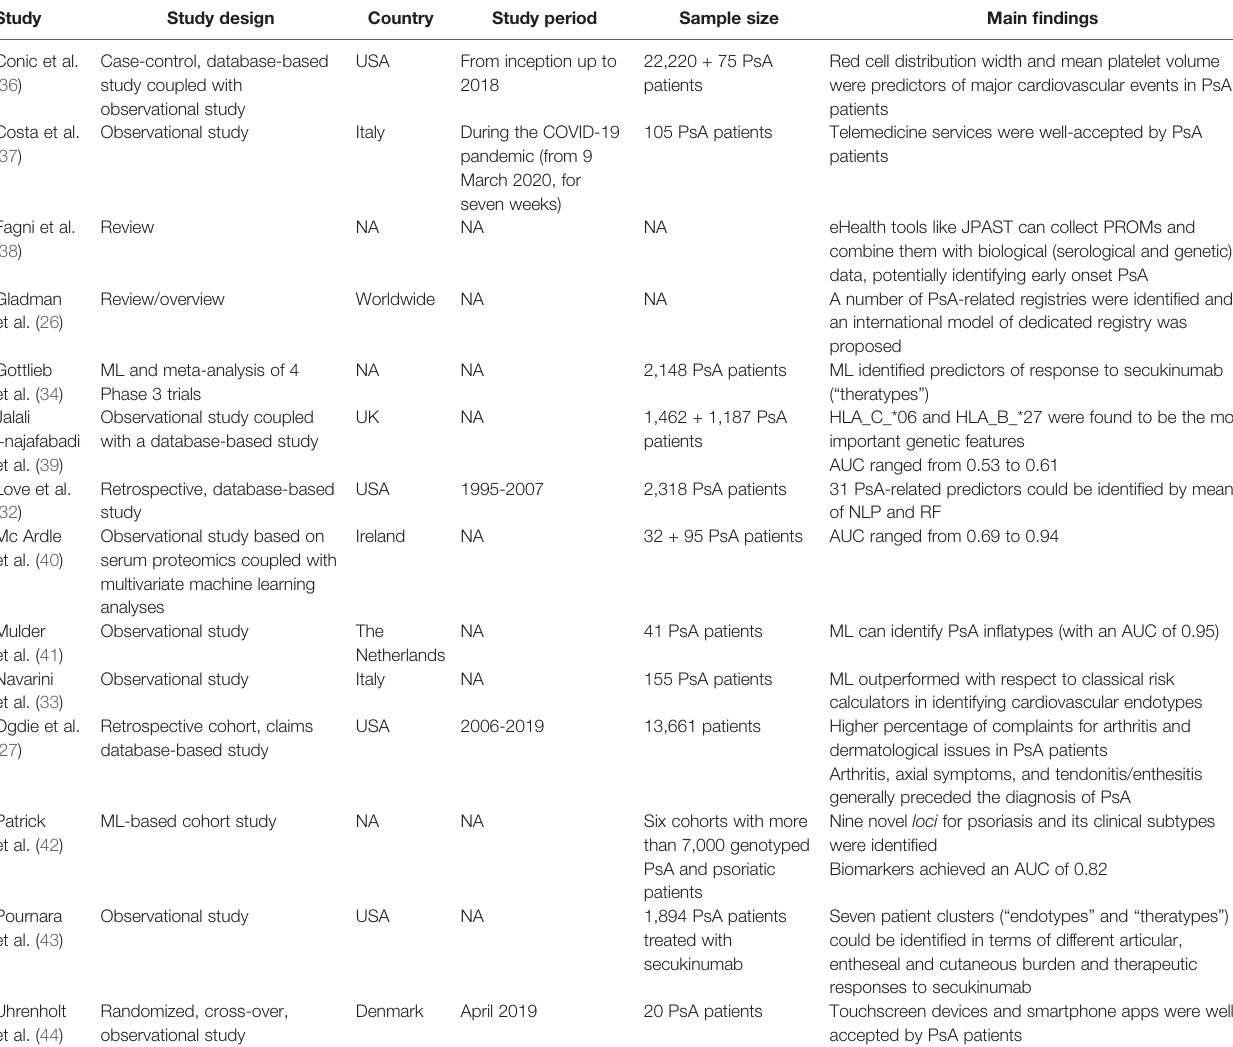
TABLE 2 | Major characteristics of studies included in the present systematic review.